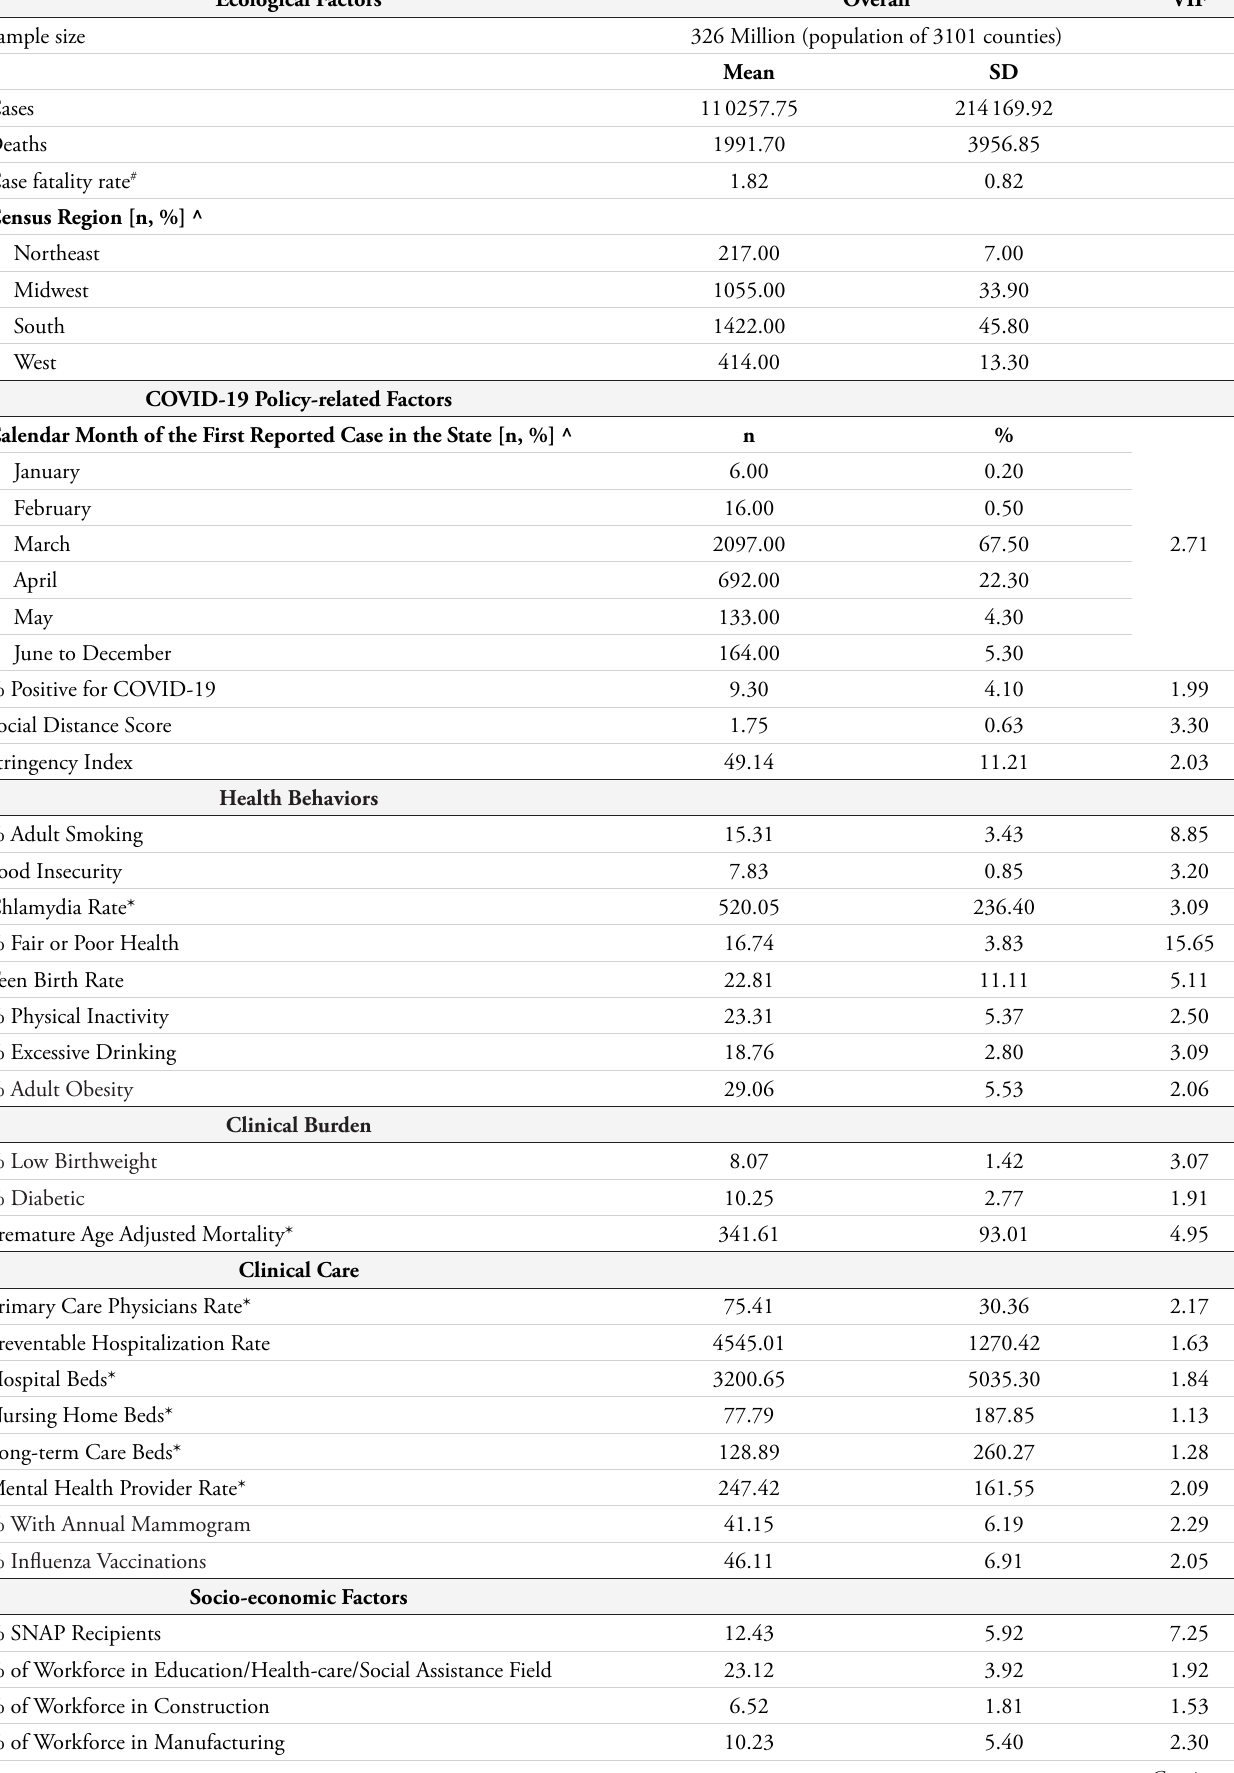
Table 2: Descriptive Statistics of Ecological Factors (N=3101) Ecological